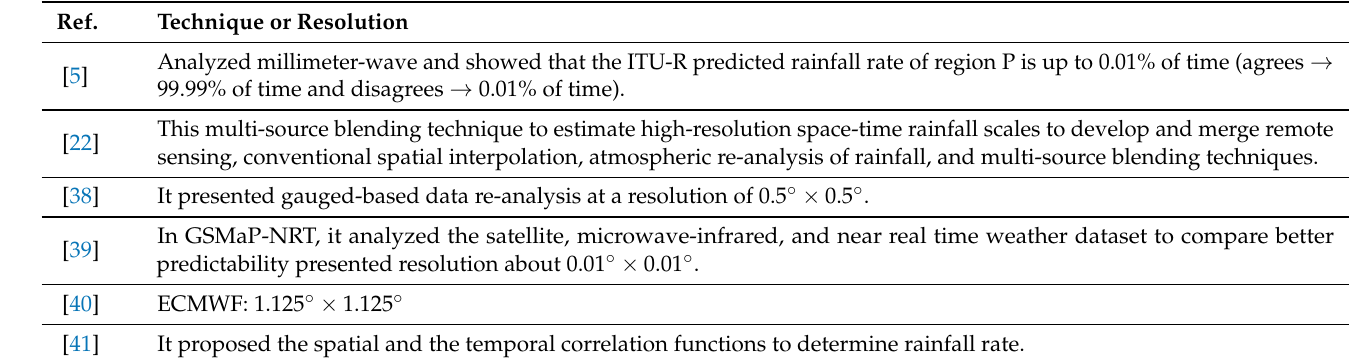
Table 2. Highly spatial resolution rainfall estimation